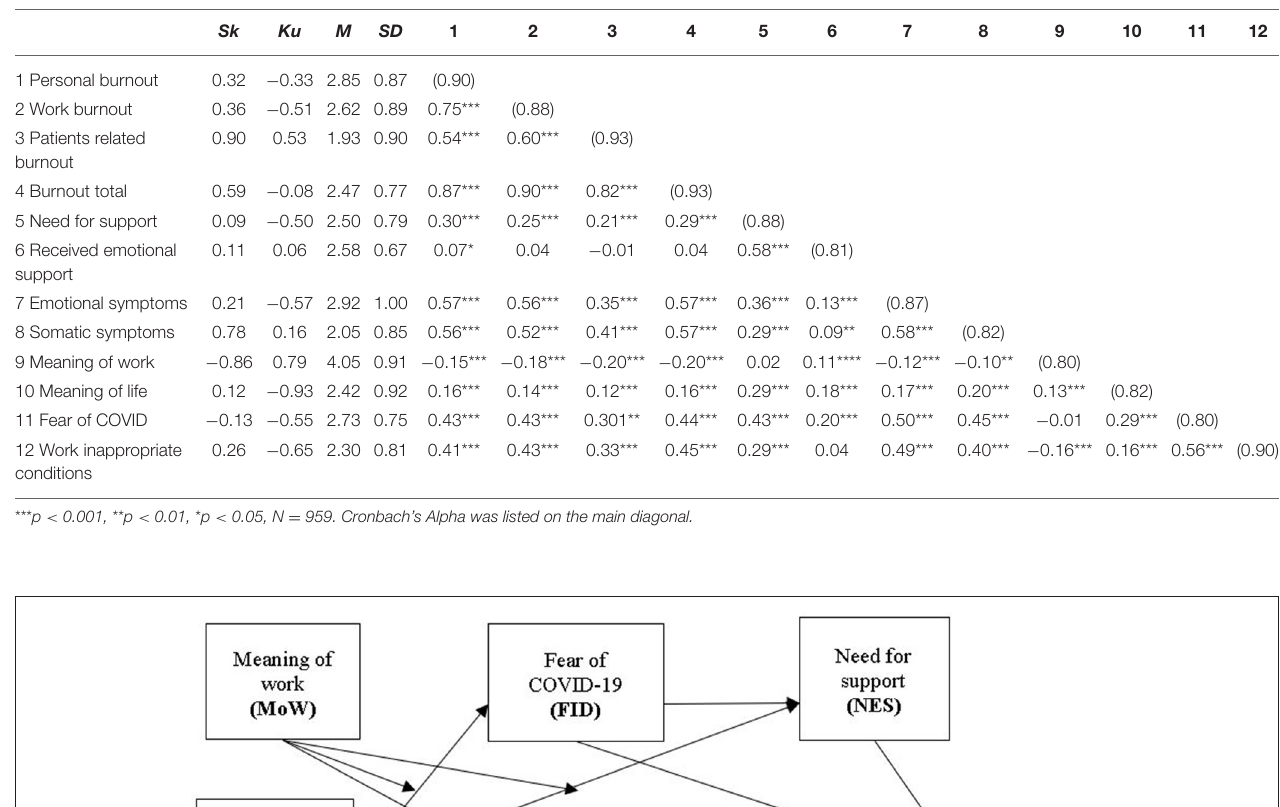
TABLE 1 | Descriptive and reliability indicators, pearson coefficient correlations.